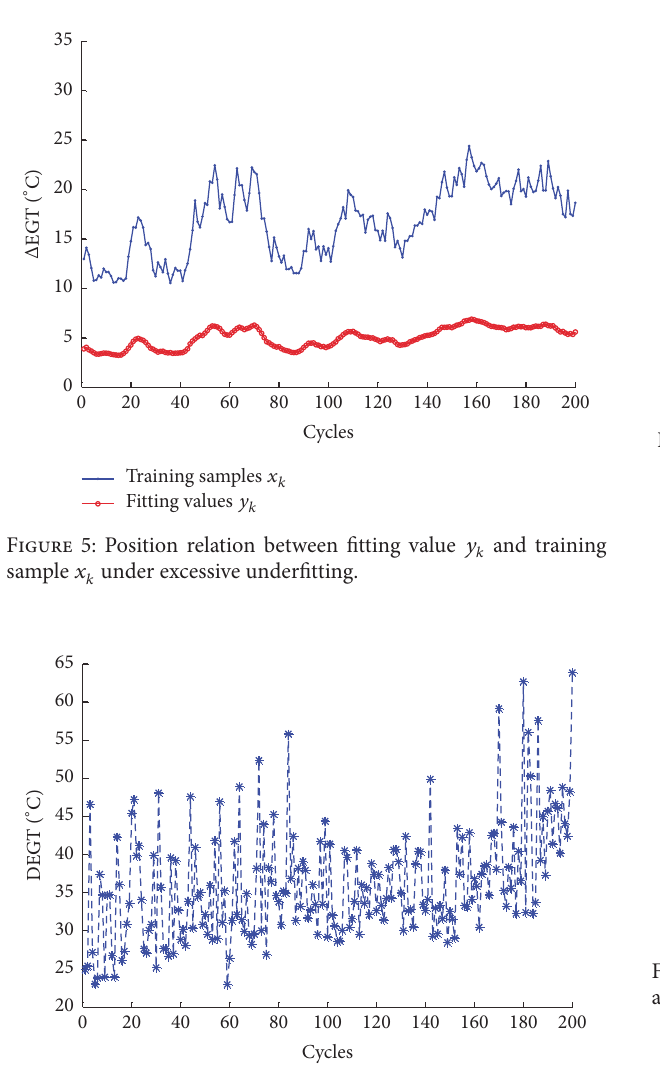
Figure 6: DEGT of an aeroengine over 200 cycles.